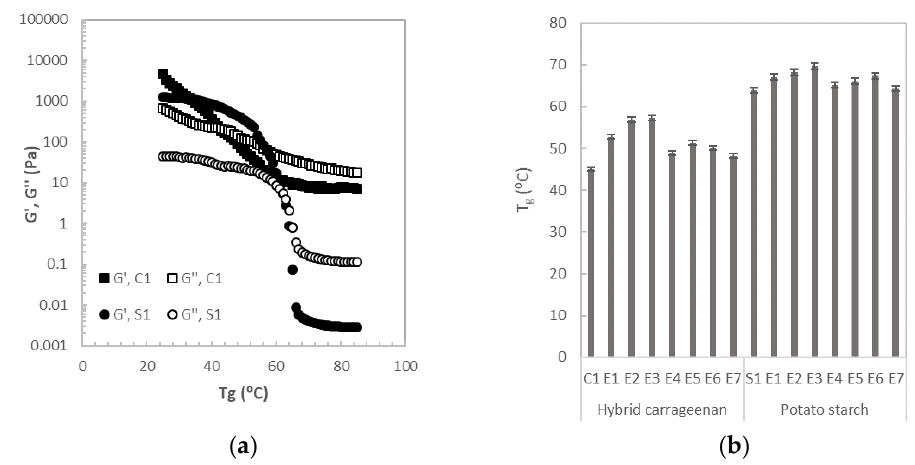
Figure 2. Cooling profiles for ( a ) the control matrices prepared with the hybrid carrageenan (C1) or potato starch (S1), as well as ( b ) the corresponding gelling temperatures ( Tg ) for all formulated matrices. Note that in this and subsequent plots, error bars were not presented when they were smaller than the symbol